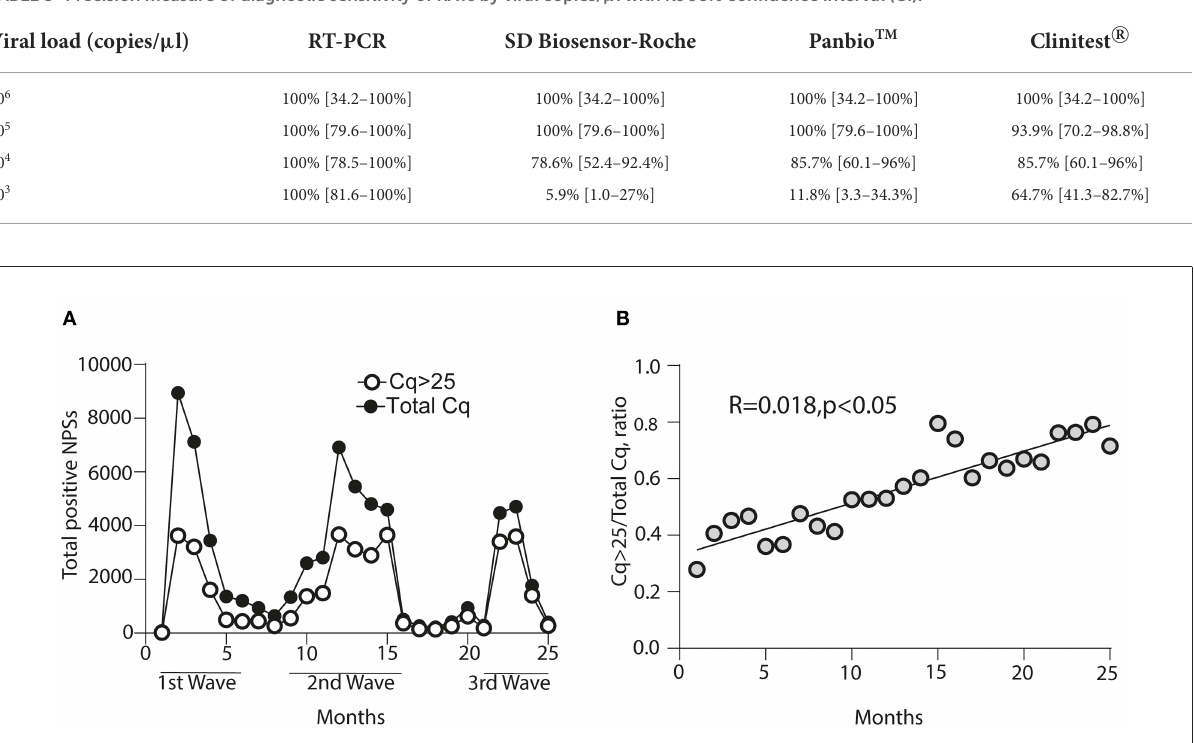
FIGURE3 Representation of the proportion for nasopharyngeal swab samples (NPSs) with a Cq-value > 25 through the waves of infections in Chile. (A) The first wave corresponds to months 1–6, the second wave to months 9–16, and the third wave to months 21–25 of the pandemic in Chile. Black circles correspond to the total Cq analyzed diagnosed as positive; empty circles represent the samples with a Cq-value > 25 in each wave of infection. (B) Linear regression is represented concerning the ratio of Cq-values > 25 over the total Cq analyzed during the first, second, and third waves of infections in